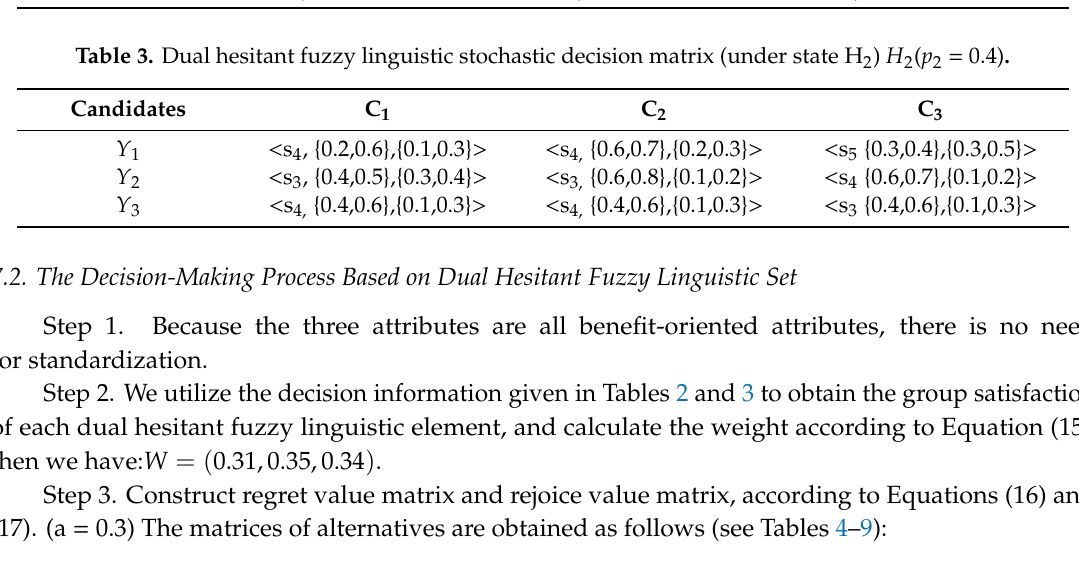
Table 2. Dual hesitant fuzzy linguistic stochastic decision matrix (under state H 1 ) H 1 ( p 1 = 0.6). Candidates C 1 C 2 C 3 Y 1 < s 3 , {0.4,0.6},{0.3,0.4} > < s 4, {0.3,0.5},{0.2,0.3} >